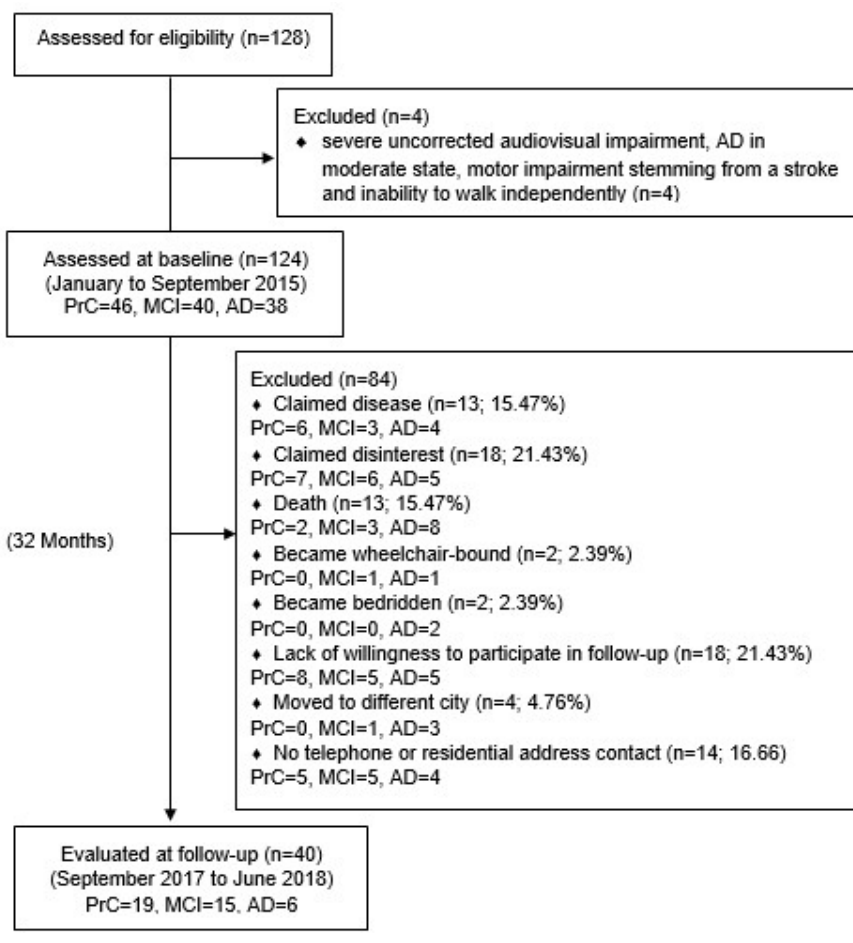
Figure 1. Sample